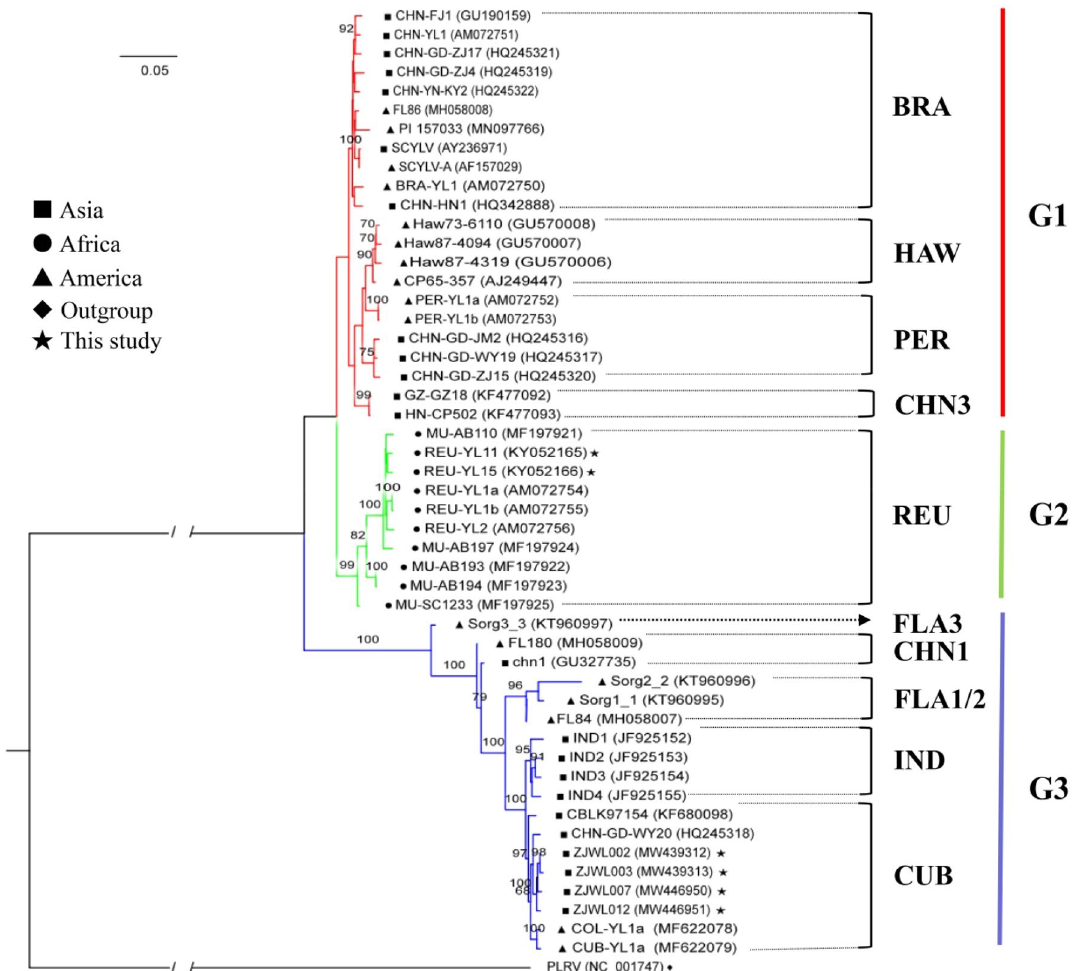
Figure 1. Maximum Likelihood (ML) phylogenetic tree constructed using IQ-TREE 1.6.12 based on nearly complete genome sequences [open reading frames (ORFs) 0–5] from 50 sugarcane yellow leaf virus (SCYLV) isolates. ML analysis was carried out using nucleotide identity distances and 1000 bootstrap replicates (Bootstrap values > 60% are shown at nodes). The scale bar indicates the number of substitutions per nucleotide. Different geographic regions are represented with red, green, and purple lines for Asia (filled square), Africa (filled circle), and America (filled triangle), respectively. The six SCYLV isolates from sugarcane obtained in the present study are indicated by the solid pentagram (filled star). A potato leafroll virus (PLRV; NCBI accession no. NC_001747) isolate served as an outgroup (filled diamond). The acronyms of each SCYLV genotype based on their originally geographical origins: BRA (Brazil), HAW (Hawaii), PER (Peru), CHN (China), REU (Reunion), FLA (Florida), IND (India), and CUB